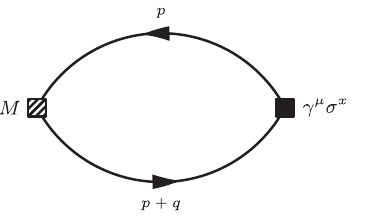
FIG. 12. Fermion bubble to calculate flux